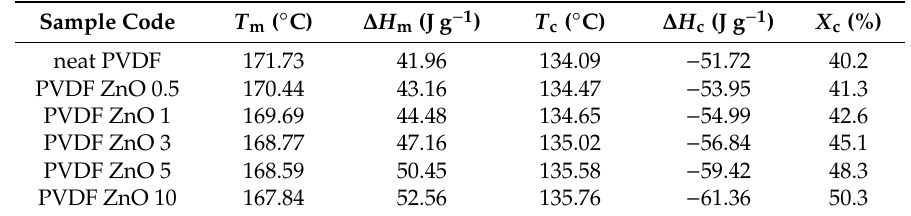
Figure 6. Differential scanning calorimetry (DSC) curves for melting ( a ) and crystallization ( b ) of neat PVDF and PVDF ZnO star-like composite films with various filler contents. Table 2. Summarized values of the DSC curves investigation for neat PVDF and PVDF ZnO star-like composite films with various filler contents.